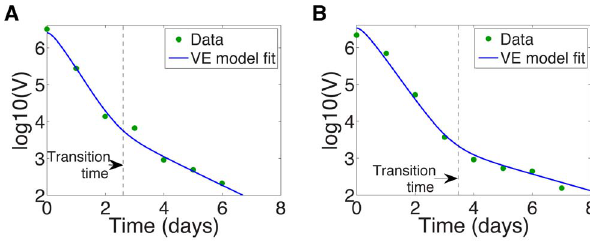
Figure 2. HCV viral load undergoes biphasic decay upon initiation of silibinin treatment at time t ~ 0 . The transition time between the first and second phases, t , is calculated by maximizing the curvature k ( t ) in equation (14), and is marked by a vertical dashed line. VE model fit of Canini et al. [19] (solid line) and HCV viral load data (dots) for (a) Patient 46, with transition time t ~ 2 : 61 days, and for (b) Patient 48, with transition time t ~ 3 : 47